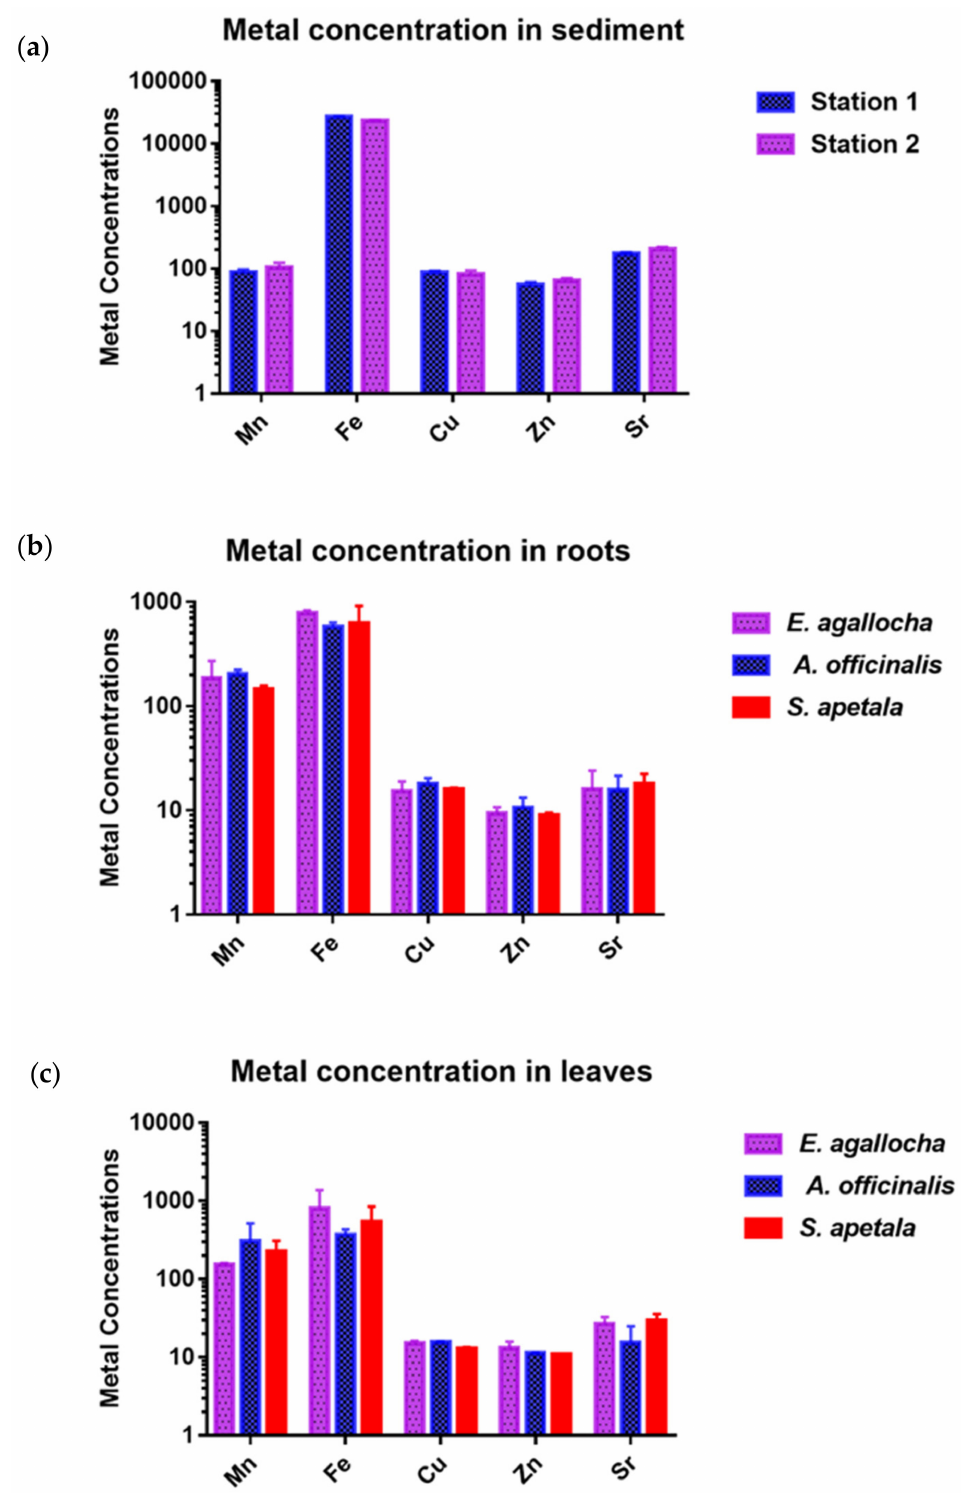
Figure 2. Metal concertation (mg/kg) in the sediments ( a ), roots ( b ) and leaves ( c ) of three mangrove species. Figure 2b and c present average values for both stations. Error bars indicate standard